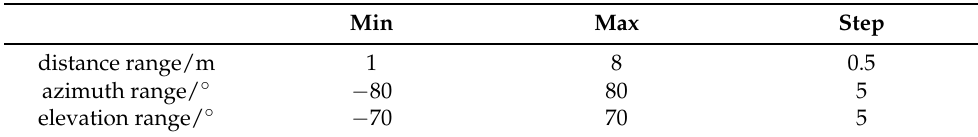
Figure 10. Training dataset with 15 different distances. For each distance, 33 azimuth and 29 elevation points were measured, and for each point, 250 samples were measured. The blue line represents the reference distance. Each distance between the UWB modules is separated with gray vertical lines. The black rectangle shows zoomed distances presented in separate figures. Table 1. Training dataset